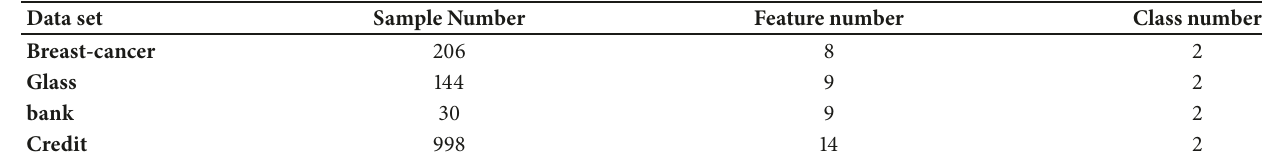
Table 1: The 4 datasets in UCI database.